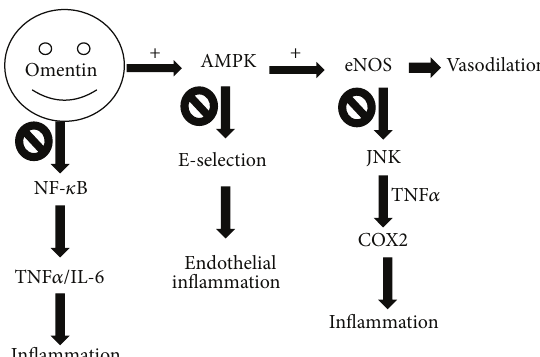
Figure 3: The anti-inflammatory mechanism of omentin. Omentin activates AMPK, which further blocks E-selection and reduces endothelial inflammation. AMPK also activates eNOS, which has vasodilation effect and blocks JNK signaling. JNK activates inflam- mation through TNF 𝛼 mediated COX2 effect. Moreover, omentin inhibits NF- 𝜅 B signaling pathway and thus inhibits inflammation. Under obese state, the production of omentin is lower which is associated with worse proinflammation and possible lung